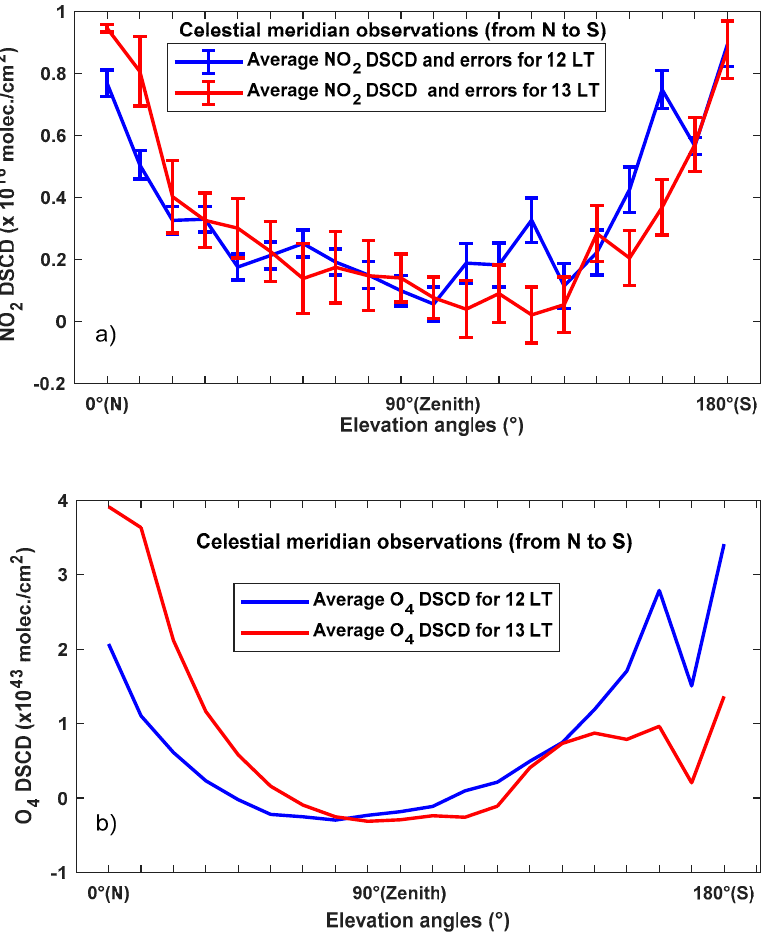
Figure 7. ( a ) NO 2 DSCD and associated errors obtained from the UGAL-2D-DOAS system working in the vertical scanning mode (VSM), on 3 June 2017; and ( b ) the O 4 DSCD for the same observations.